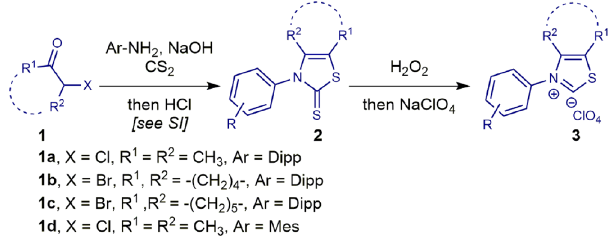
Fig. 2 Synthesis of thiazol-2-ylidene precursors. See Supplementary Method 2 for details.